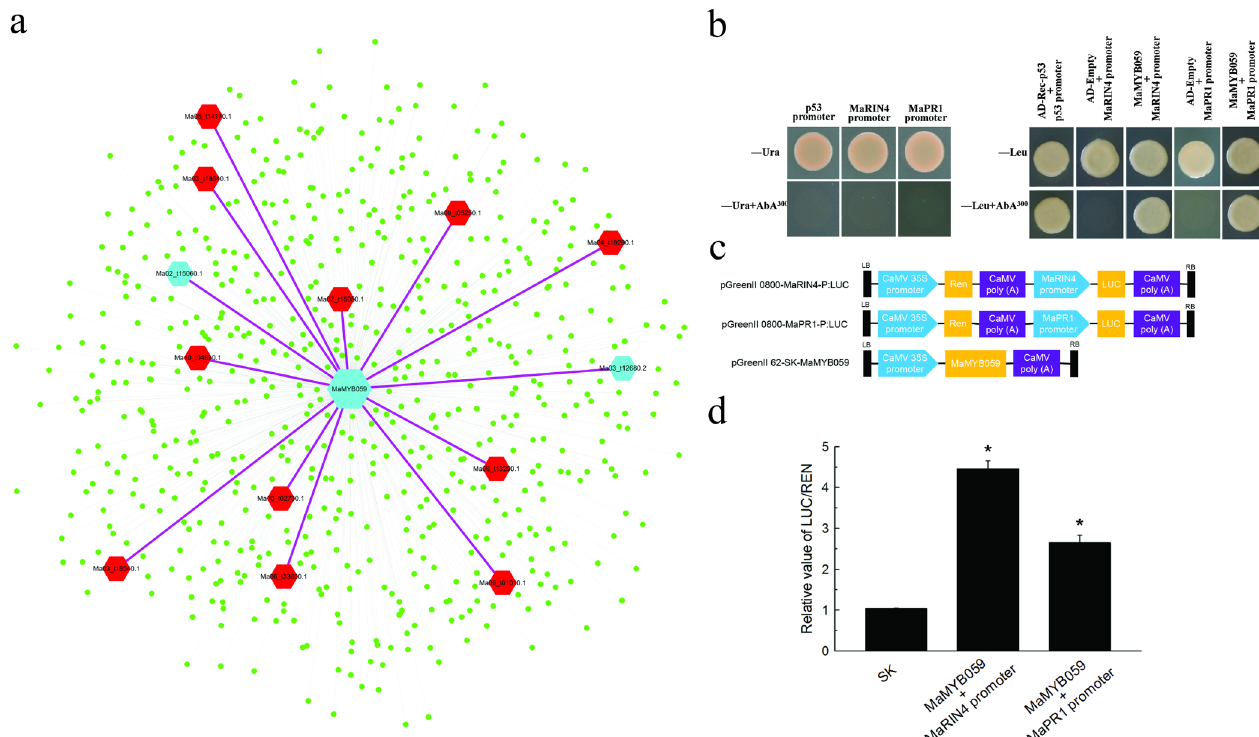
Figure 8 . MaMYB059 individually activates the MaRIN4 and MaPR1 promoters. ( a ) Co-expression network of MaMYB059 by WGCNA. ( b ) Yeast one hybrid assay of MaMYB059 binding with MaRIN4 and MaPR1 promoters. ( c ) Schematic diagrams of the effector and reporter constructs used for the dual LUC assay. ( d ) MaMYB059 activates MaRIN4 and MaPR1 promoters in dual-luciferase assays. p values < 0.05 were considered statistically significant (*).